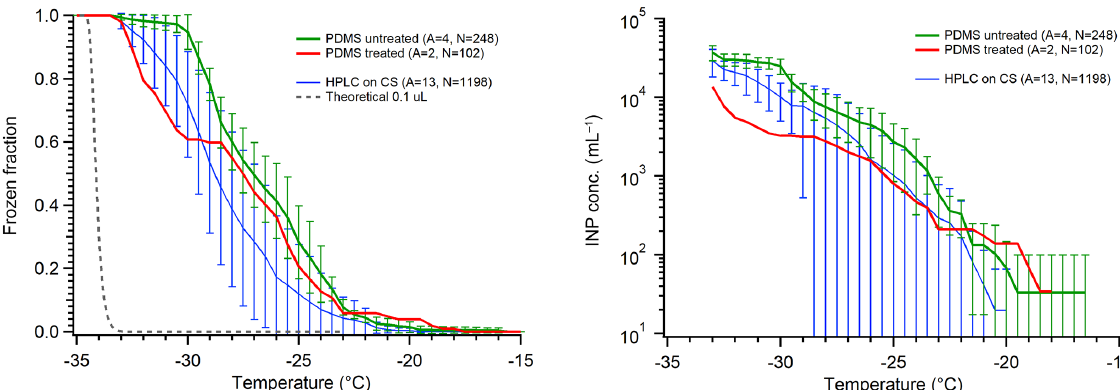
Figure 9. Measurements of HPLC pure water droplet freezing on polydimethylsiloxane (PDMS) are shown in red and green, following Fig. 5. The data from small droplets on a silanized cover slip are displayed for comparison in blue (Fig. 5, blue). The PDMS data were obtained using treated (red) and untreated (green) PDMS polymer with small droplets. The parentheses next to each legend entry contains the number of arrays of droplets ( A ) and the total number of droplets across all arrays ( N ). Error bars on green data show standard deviation from replicate arrays, while the red data are combined into one series as explained in section 2. The gray dashed line indicates the theoretical homogeneous freezing curve of 0.1µL droplets, using the parameterization of Koop and Murray (2016).